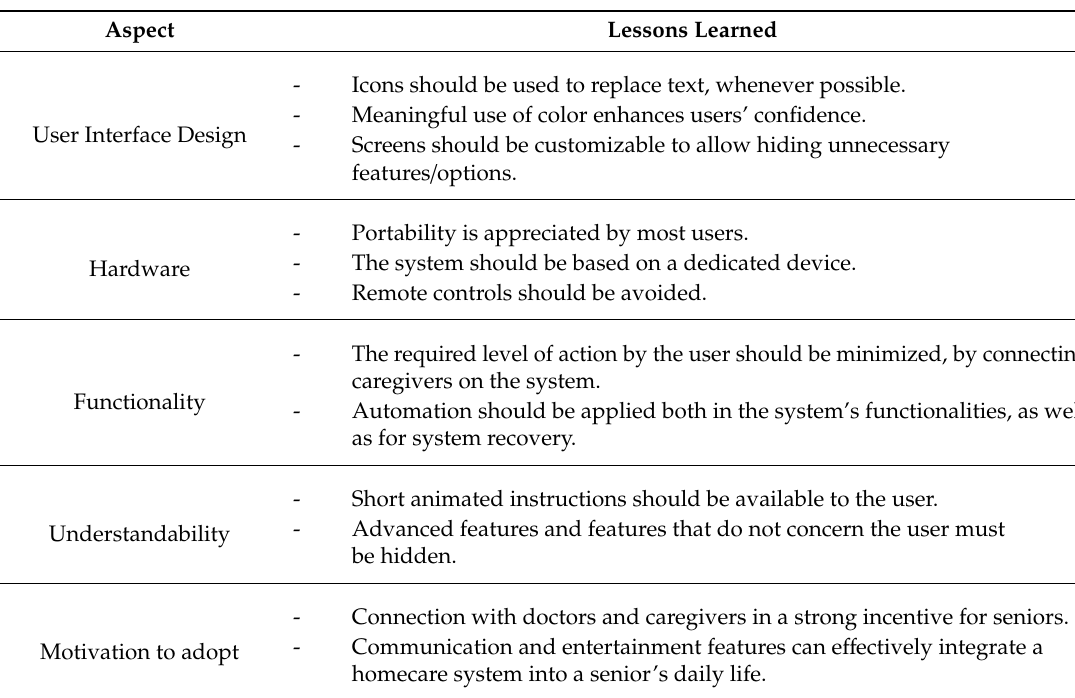
Table 2. Practical guidelines for increasing usability of elderly homecare